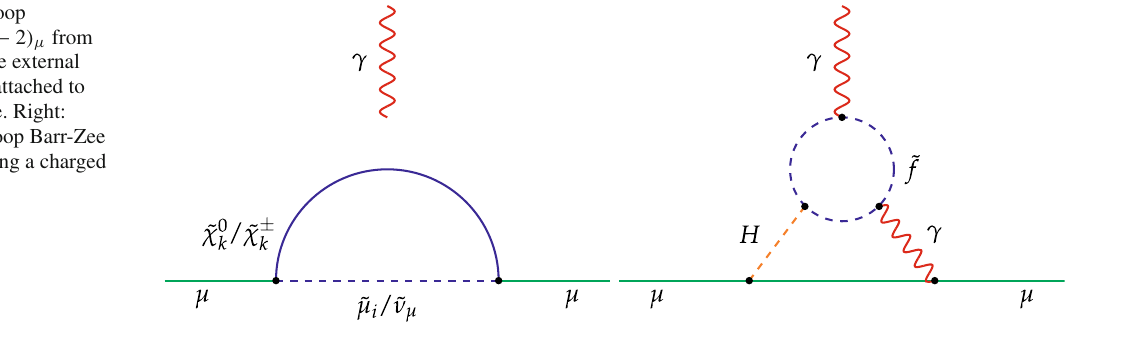
ing that g − 2 be explained. Therefore, correlated effects in h → μ + μ − [289], and to a lesser extent in Z → μ + μ − [288,290], arise which can be used to (indirectly) distinguish the two LQ representations at future colliders. In fact, cor- relations with h → μ + μ − and Z → μ + μ − become of interest for a wide range of chirally enhanced scenarios, see Ref.